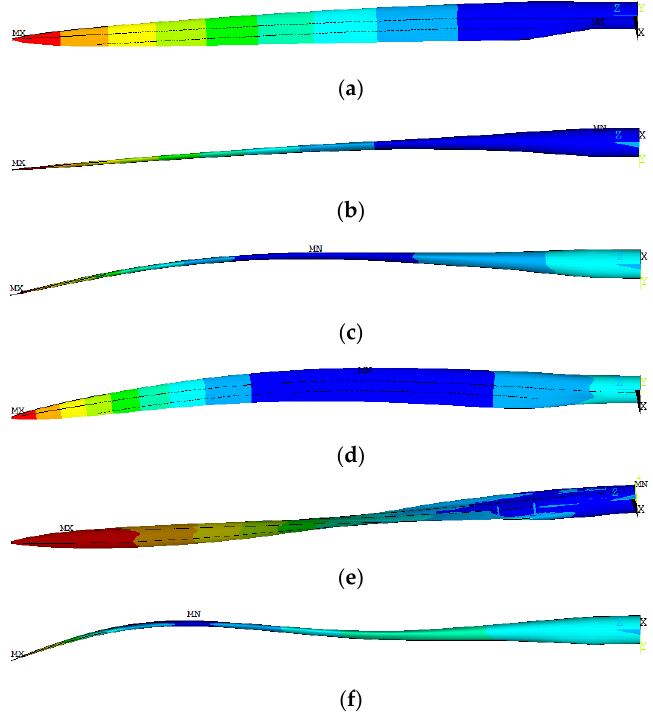
Figure 16. Mode shape of the optimized blade. ( a ) First mode shape; ( b ) second mode shape; ( c ) third mode shape; ( d ) fourth mode shape; ( e ) fifth mode shape; and ( f ) sixth mode shape.